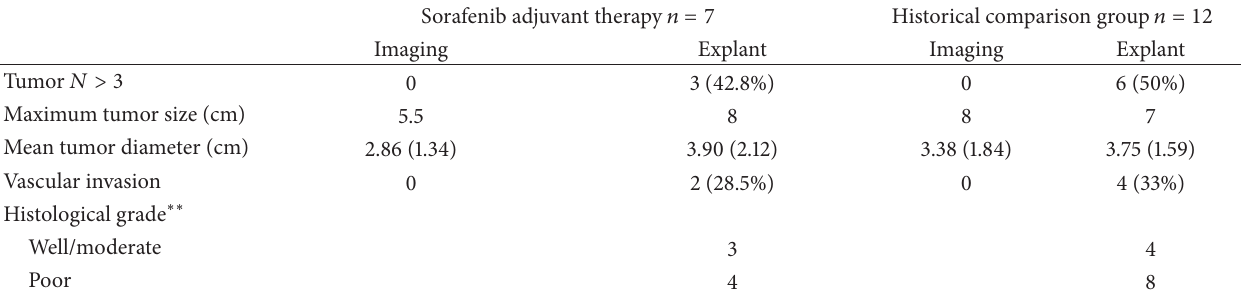
Table 2: Pre-LT imaging and explant tumor characteristics.